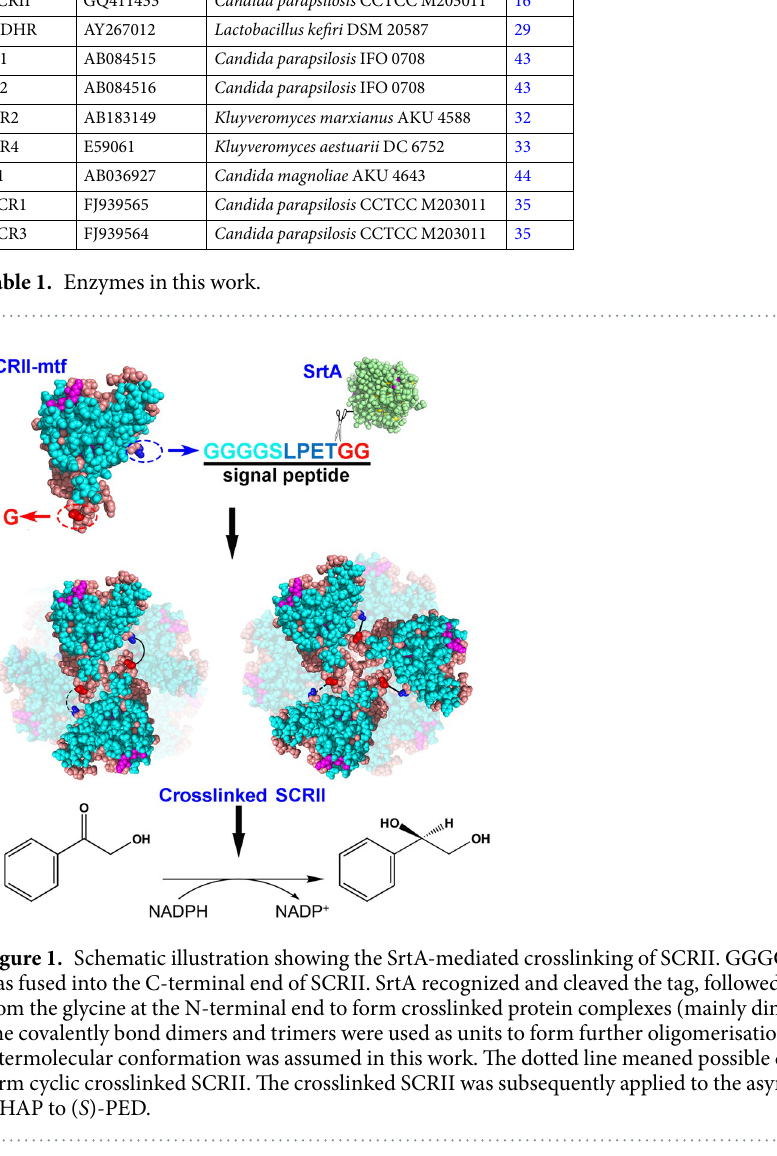
protein-lipid 10 , and protein-surface conjugates 11 and cyclised peptides 12 . Wu et al . used SrtA for chemoenzy-